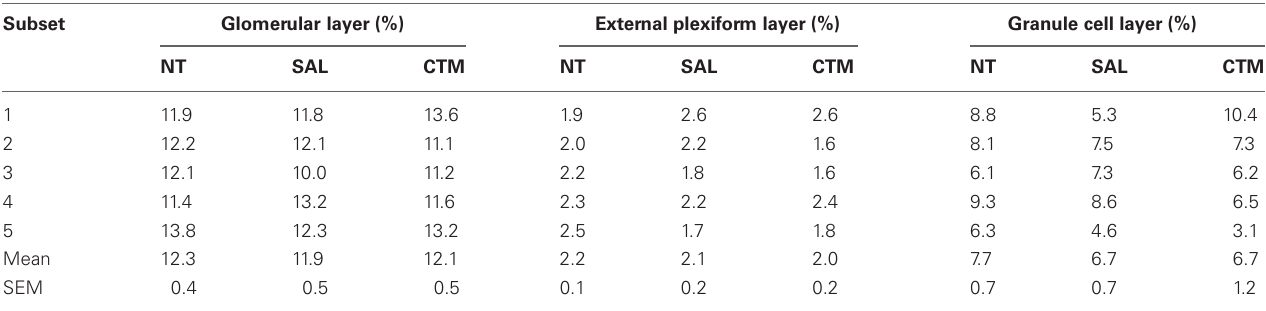
Table 2 | SERT-ir fiber density in the olfactory bulb of female rats. Subset Glomerular layer (%) External plexiform layer